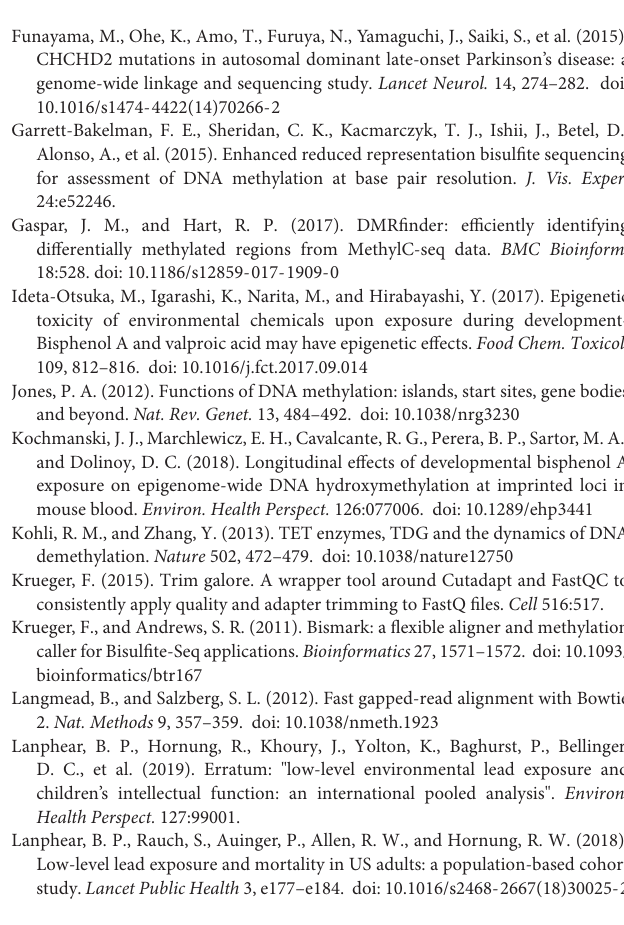
FIGURE S1 | The genome-wide weighted sample correlations. FIGURE S2 | The distribution of DNA methylation changes of differentially methylated cytosines (DMCs) and differentially methylated regions (DMRs). FIGURE S3 | The overlap among differentially methylated cytosines (DMCs) among sexes and tissues. FIGURE S4 | Venn diagram showing the number of DMR related genes detected from different tissues in two sexes along with associated pie graph depicting the percentage of methylation directions of each gene set. The DNA methylation changes are expressed as lead vs